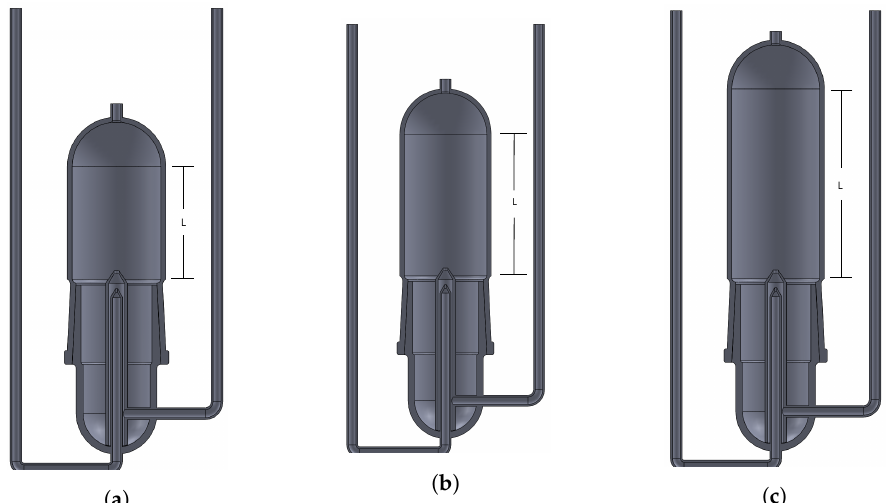
Figure 2. Burner height of ( a ) L = 60 mm, ( b ) L = 80 mm, and ( c ) L = 100